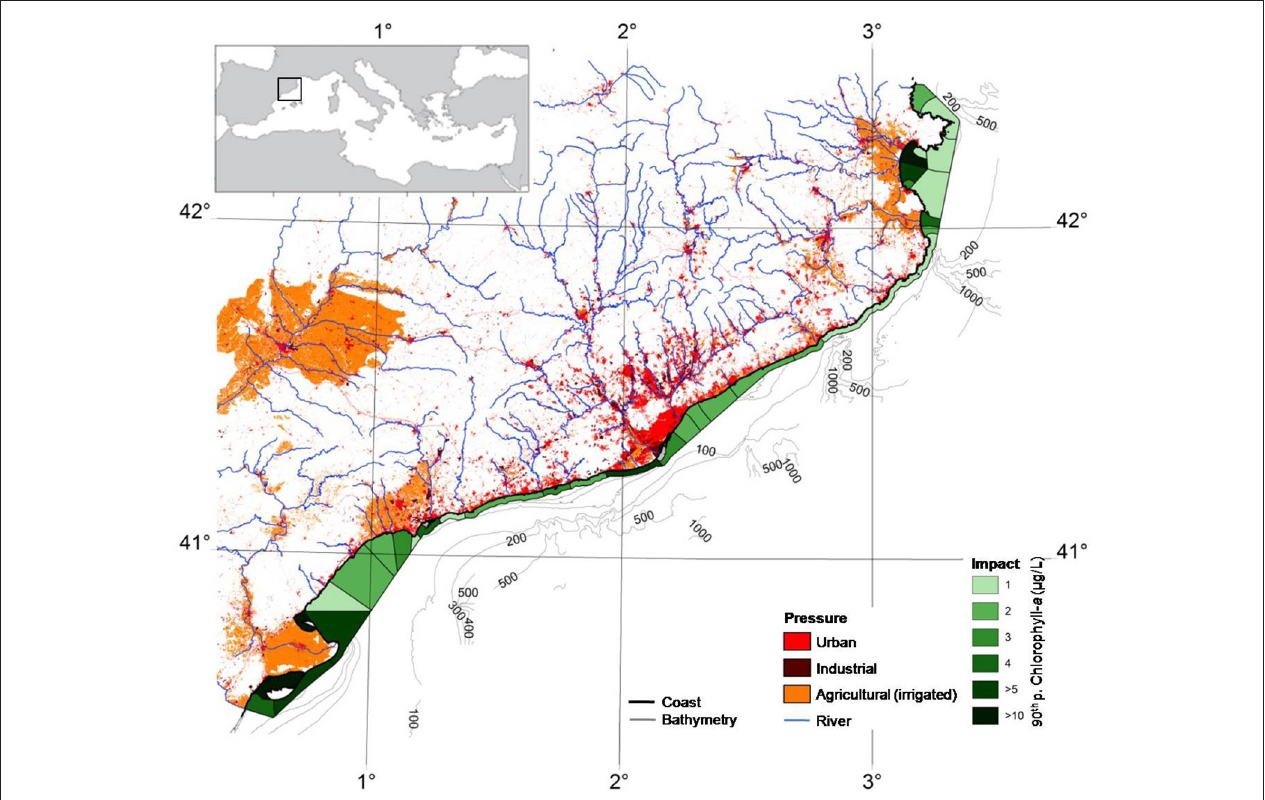
FIGURE 3 | Map of the Catalan coast showing the continental pressures related to LUSI on land calculated using the 2009 Mapa de Cobertes del Sòl de Catalunya and the 90th percentile values of chlorophyll- a ( µ g/L) in coastal waters (shown as water bodies), as a measure of impact. Urban land use is shown in red, industrial land use in brown and agricultural (irrigated) land use in orange. Rivers are shown in blue and the coastline in black. Water bodies are shown in green, with the shade depending on the chlorophyll- a value (assigned based on direct integer values). There are no chlorophyll- a data for harbors, indicated, as for the bathymetry, in